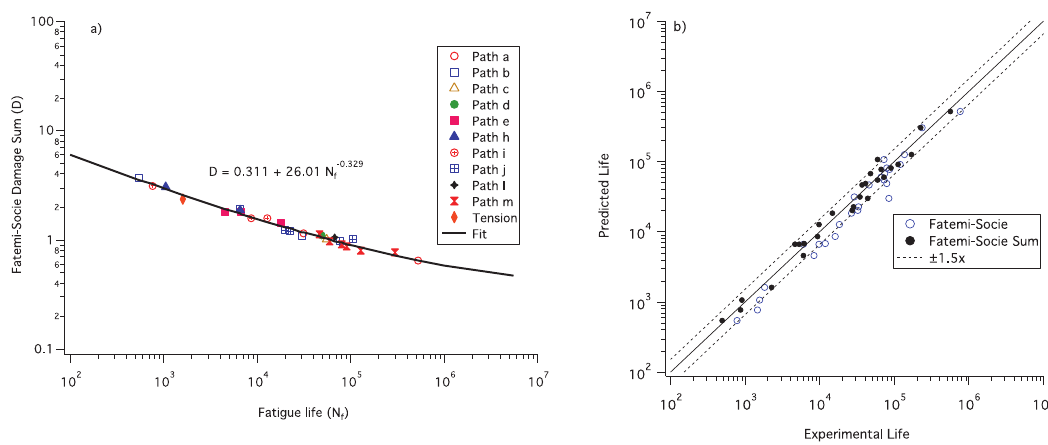
Figure 5: Fatigue damage and fatigue life prediction. a) fatigue damage and fatigue life correlation. b) Comparison between fatigue life prediction using the standard Fatemi-Socie critical plane parameter and the proposed damage summation